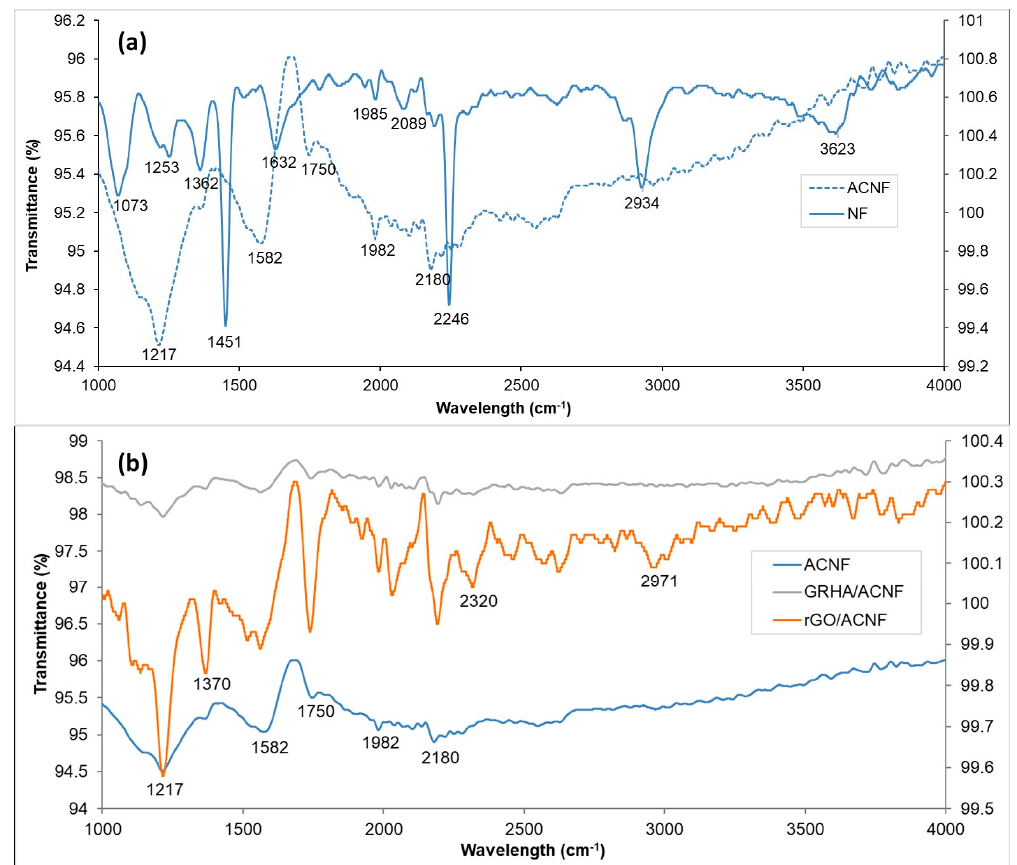
Figure 4. FTIR spectra of pristine and composite nanofibers ( a ) prior to activation and ( b ) after activation. ACNF: activated carbon nanofibers, rGO: